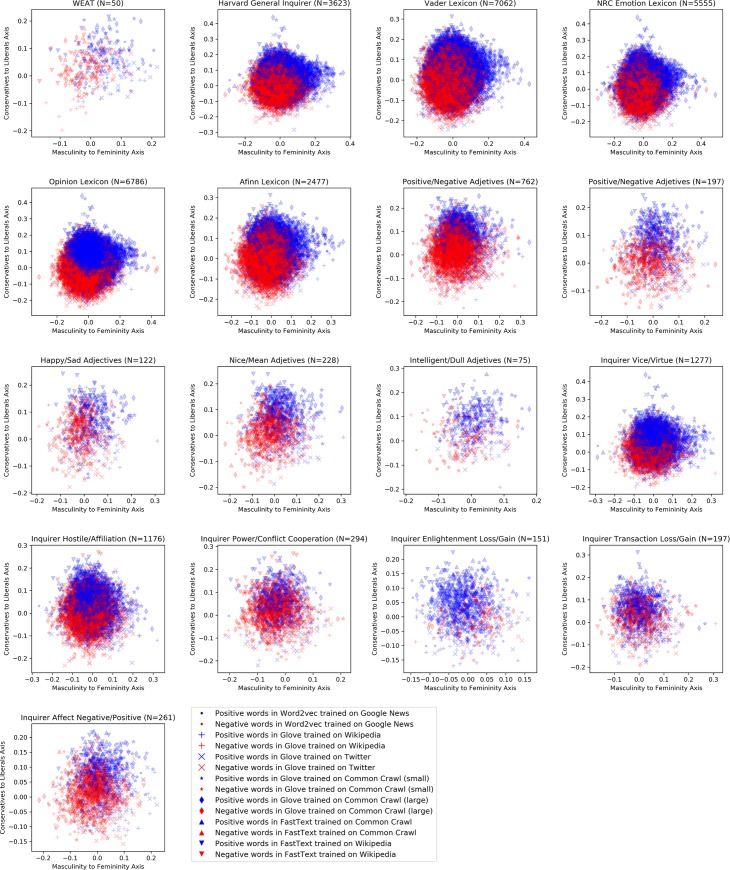
Projections of words in 17 sentiment lexicons onto gender and political orientation axes for the 7 word embedding models analyzed.Positive words are color-coded in blue and negative words are color-coded in red.